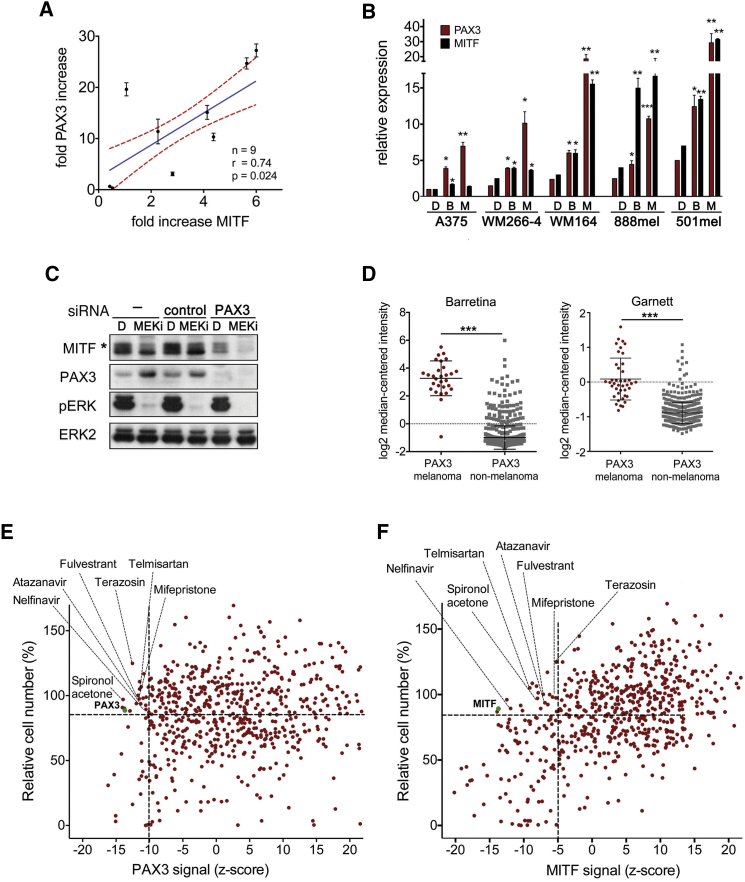
A Drug Screen to Target PAX3 and MITF(A) Correlation of fold change in MITF and PAX3 expression (mean ± SD) in melanomas of patients (n = 9) undergoing treatment with vemurafenib or dabrafenib/trametinib combination. Shown is the mean (blue) with the 95% confidence interval (red dashed line).(B) qRT-PCR analysis for PAX3 and MITF expression (mean ± SEM, ∗p < 0.05; ∗∗p < 0.01; ∗∗∗p < 0.001) in a panel of melanoma cell lines treated with DMSO, vemurafenib (B) or selumetinib (M) for 48 hr.(C) Western blot of WM266-4 cells untreated or treated with a control or PAX3-specific siRNA in the presence of DMSO or PD184352 (MEKi, 24 hr). The asterisk indicates an ERK-phosphorylated MITF form.(D) PAX3 expression analysis of the Barretina and Garnett datasets deposited in Oncomine. Data show scatter dot plots, indicating the mean ± SD. ∗∗∗p < 0.001.(E) WM266-4 cells treated with an FDA-approved drug library were analyzed for PAX3 expression and viability. Values are presented as % relative cell number and Z score. Drugs with a survival score >90% and a Z score <−10 were nominated candidate drugs.(F) Drug screen for MITF expression as described in (E). Values are presented as % relative cell number and Z score. Drugs with a survival score >90% and a Z score <−5 were nominated candidate drugs. See also Figure S2.